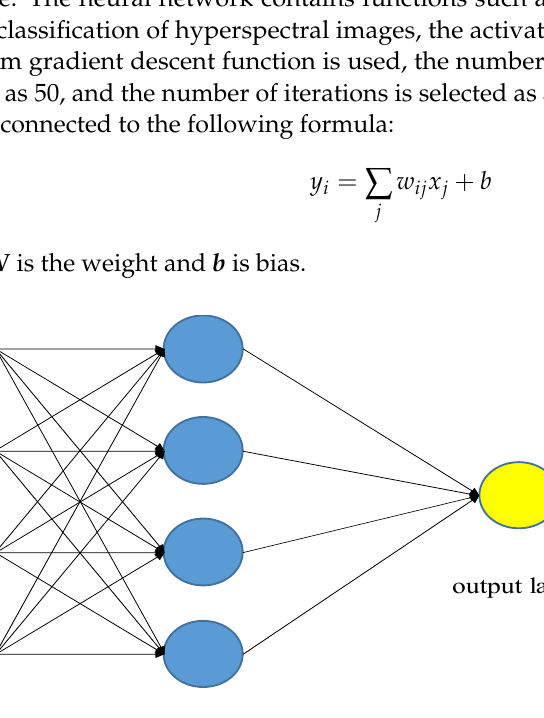
Figure 3. Neural network structure